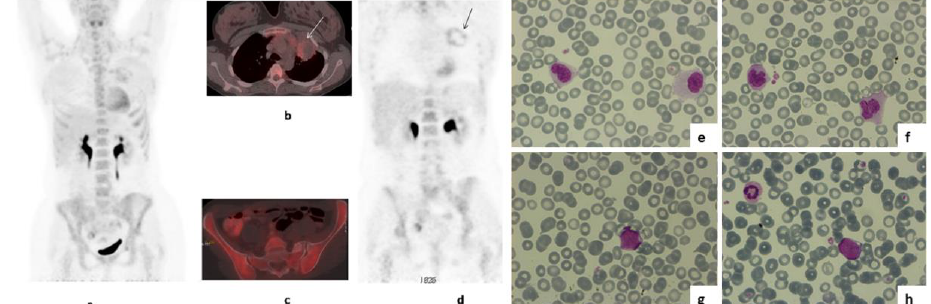
Figure 1. MIP ( a ) axial-fused ( b , c ) and coronal PET images ( d ) of 18 FDG PET/CT performed during the patient’s follow up, 6 months after the completion of treatment with R-DA-EPOCH. There is diffusely increased 18 FDG uptake by the bone marrow with intensity higher than that of the liver ( a , c , d ). As no Granulocyte Colony Stimulating Factor (G-CSF) was administered, this was a new finding. Increased peripheral, “ring like” 18 FDG uptake by the residual large mediastinal mass was also present with intensity higher than that of the liver—-SUVmax lesion :4 versus SUVmax liver :2,6 ( b white arrow, d black arrow). Peripheral blood smear simultaneously revealed abnormal monocytes ( e , f ), and blast cells appeared one month later, when the evolution of t-MDS into acute myeloid leukemia was demonstrated ( g , h ).